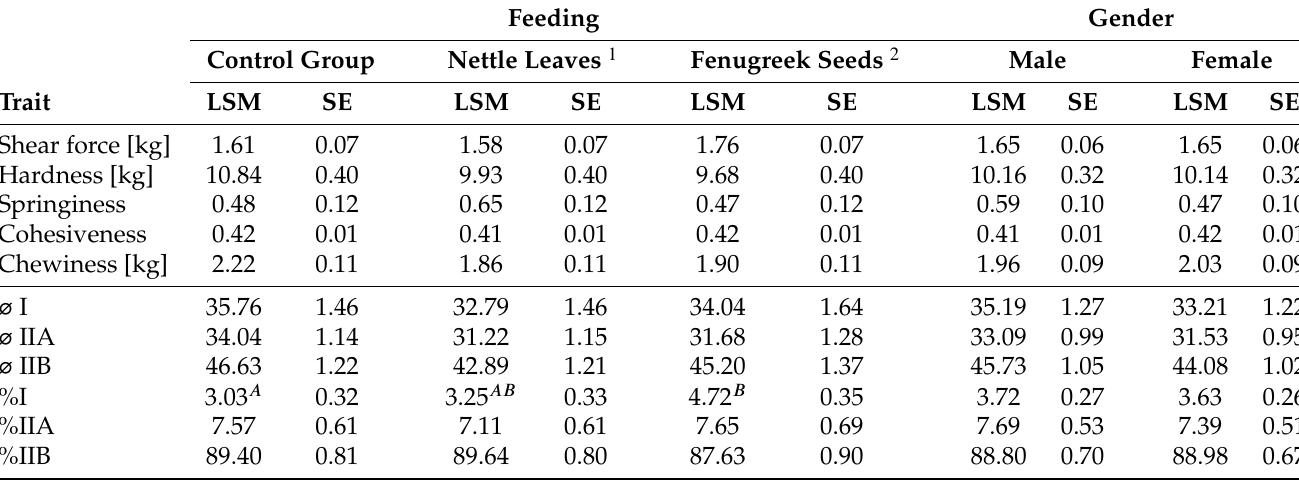
Table 4. Least square means (LSM) with standard errors (SE) of texture and muscle fibre traits ( ⌀ —diameter and %— percentage), by feeding and